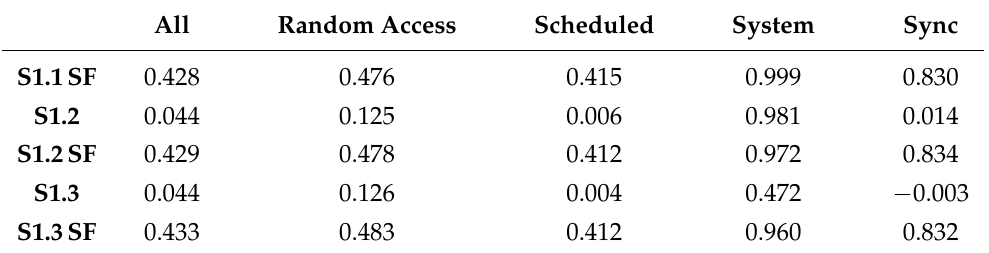
Table 5. Collision probability improvement for sub-scenarios and SF-based message